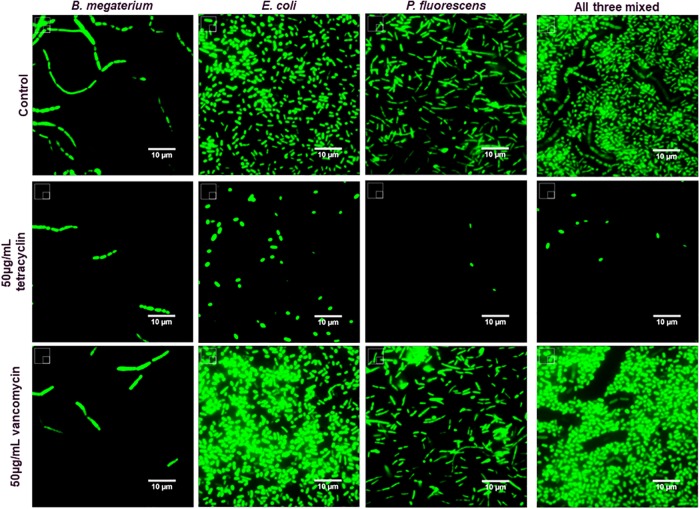
Representative images of microbes treated with antibiotics.Representative images of control and antibiotic-treated microbes stained with the DNA dye SYTOX Green are presented. Images were normalized for veiwing using ImageJ within each genus for comparison, mixed microbe samples were normalized to each other.